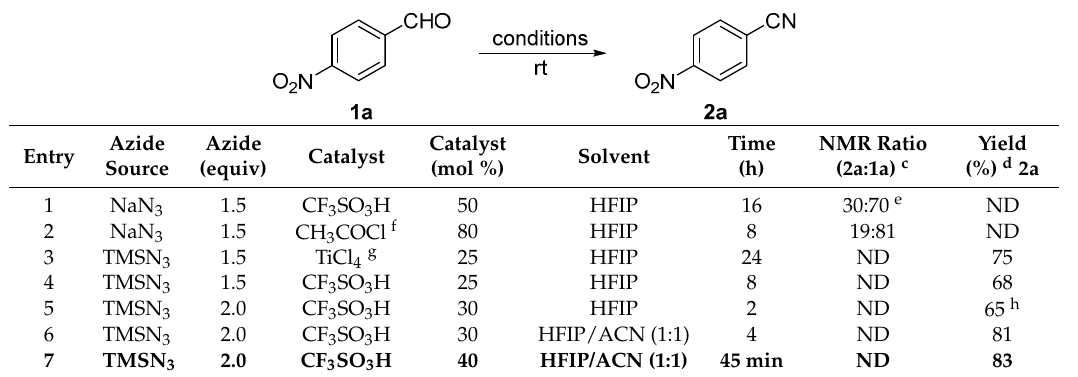
Table 1. Optimization of the Schmidt Reaction of 4-Nitrobenzaldehyde 1a a,b .